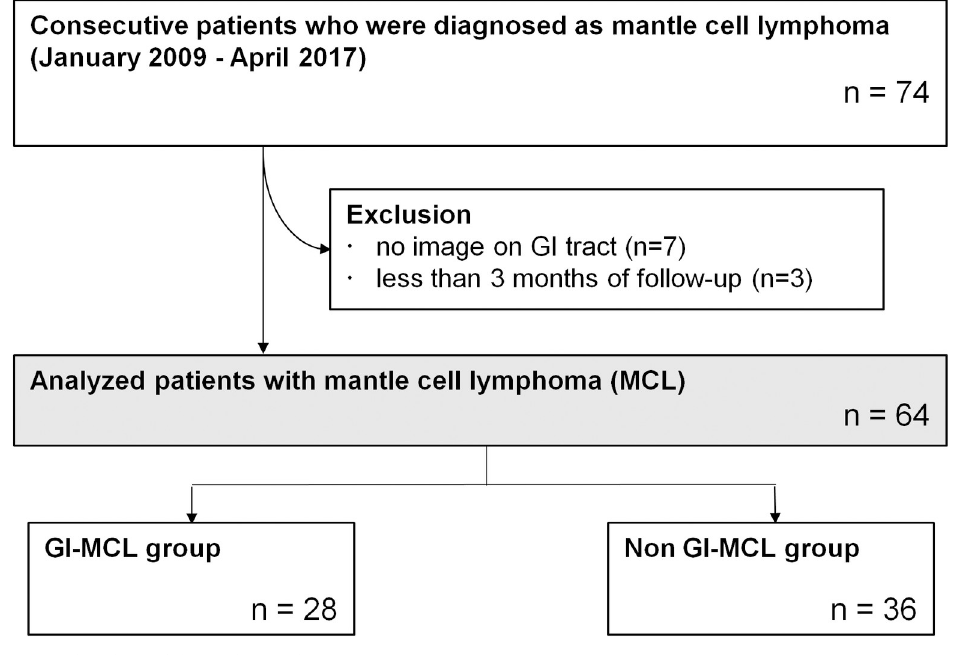
Fig 1. Flowchart of the study